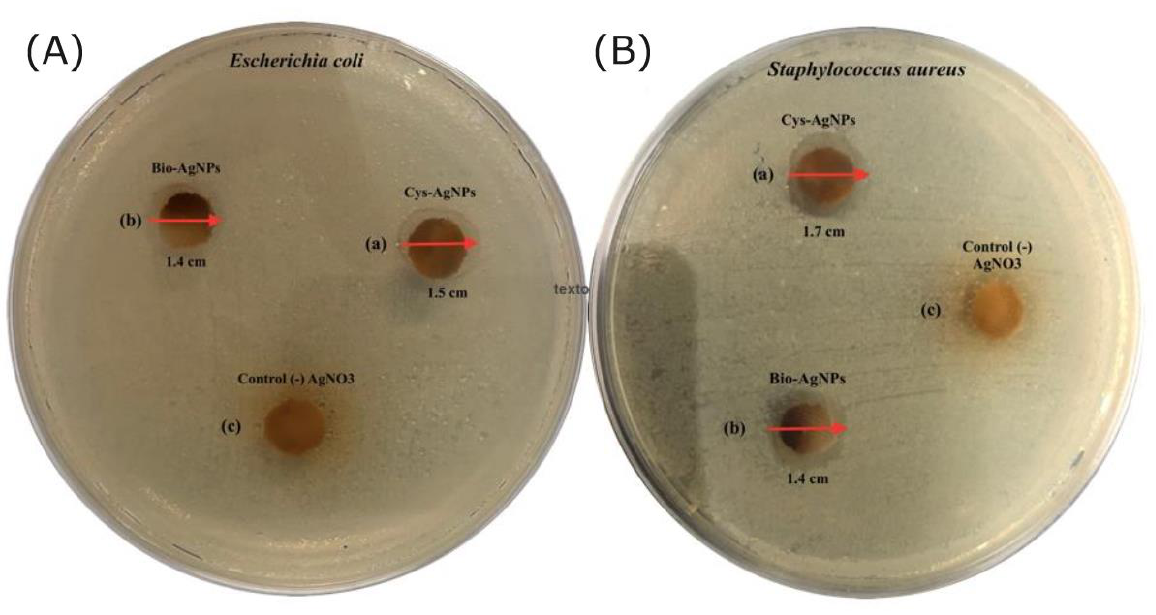
Figure 5. Inhibition zone test of the ( a ) Cys-AgNP cotton, ( b ) bio-AgNP cotton. and ( c ) control (-) AgNO 3 in Escherichia coli ( A ) and Staphylococcus aureus ( B